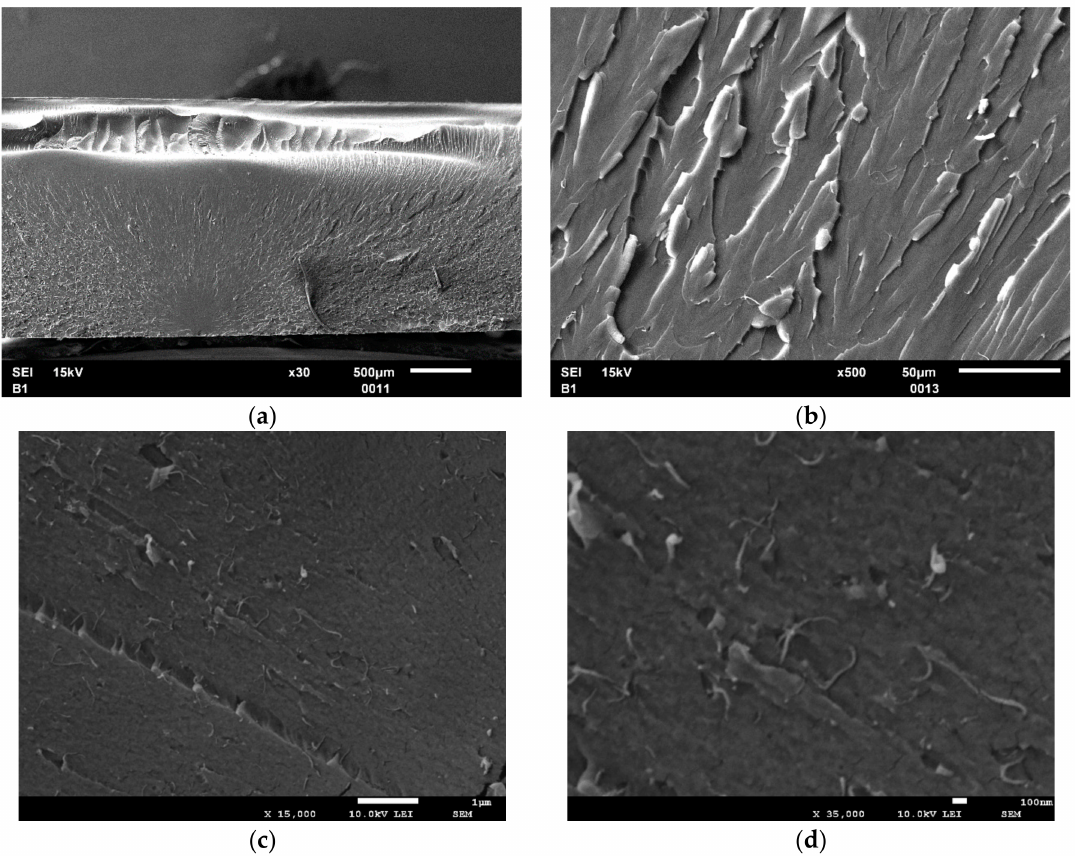
Figure 2. SEM micrographs of fracture surface of 0.2 wt.% MWCNT-modified epoxy at magnifications 30 × ( a ); 500 × ( b ); 15,000 × ( c ); 35,000 × ( d